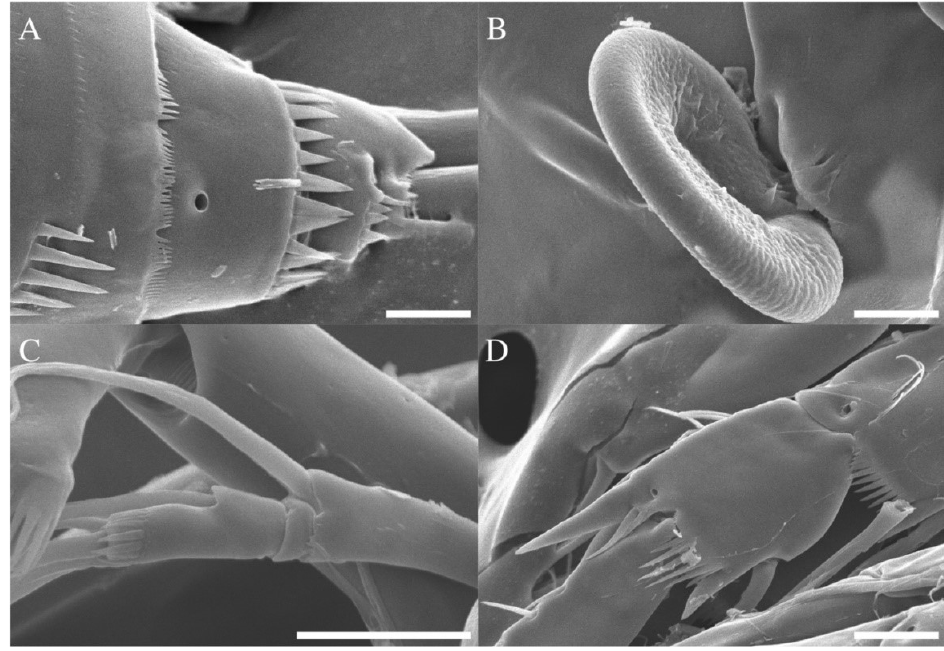
Figure 8. Robertgurneya jejuensis sp. nov. Female. SEM photographs. ( A ) Caudal ramus, lateral. ( B ) Epicopulatory bulb in genital field. ( C ) A2 exopod. ( D ) P2 segments with distal ornamentation. Scale bars: 10 μm.